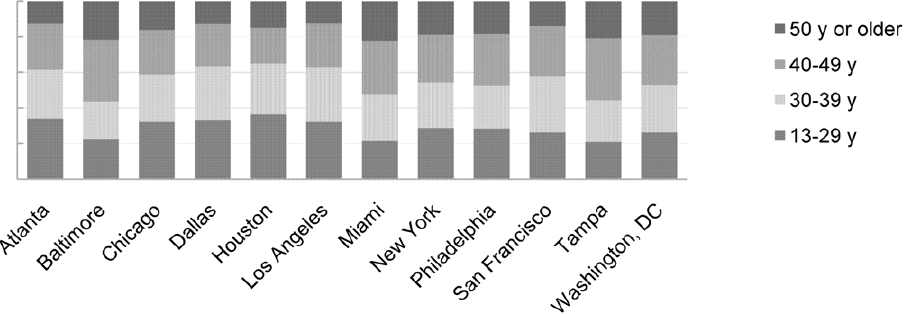
Figure 1. Percentage of adolescents and adults diagnosed with HIV, by area of residence and age, 12 U.S. Statistical Metropolitan Areas, 2007.